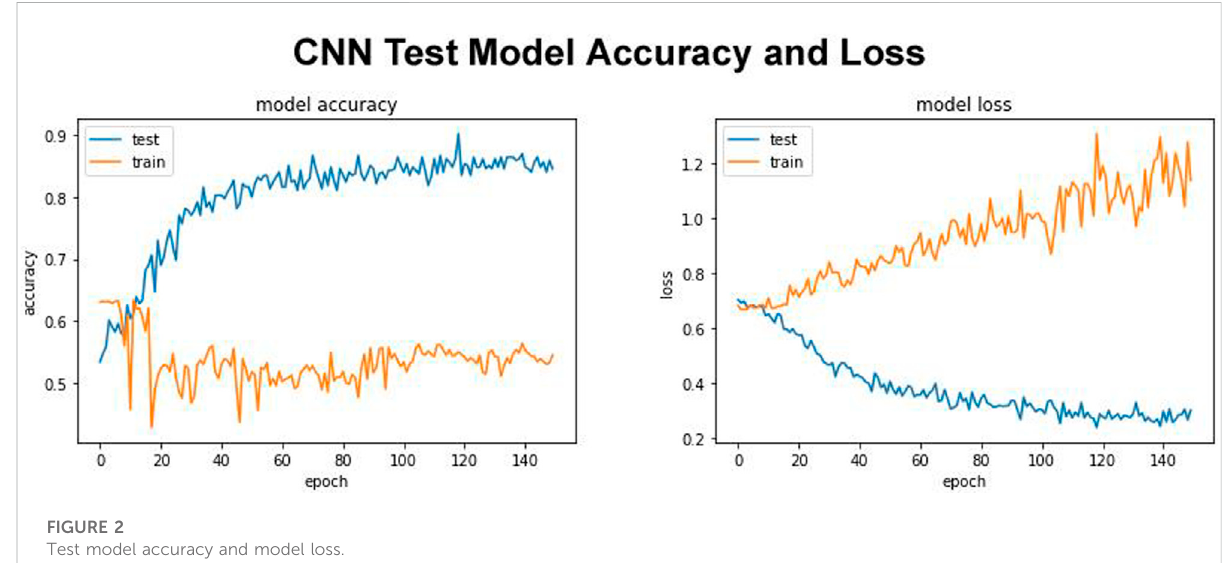
FIGURE 2 Test model accuracy and model loss.